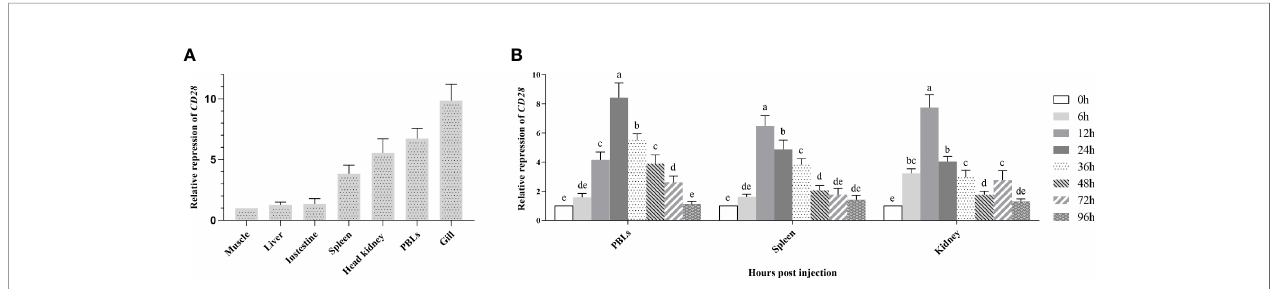
FIGURE 2 | Gene expression analysis. (A) Expression of CD28 in fl ounder tissues. Relative expression levels of CD28 in different tissues were normalized fi rst concerning the expression level of b -actin and then compared with the average expression level in the muscle where the expression level was lowest and de fi ned as 1, n=9. (B) Induced expression analysis of CD28 after KLH stimulation in PBLs, spleen, and head kidney. The relative expression values were averaged from the data in three parallel reactions, and the results were obtained from at least three independent experiments, n = 9. Different letters above the bar represent the statistical signi fi cance ( p < 0.05). Error bars represent standard errors of